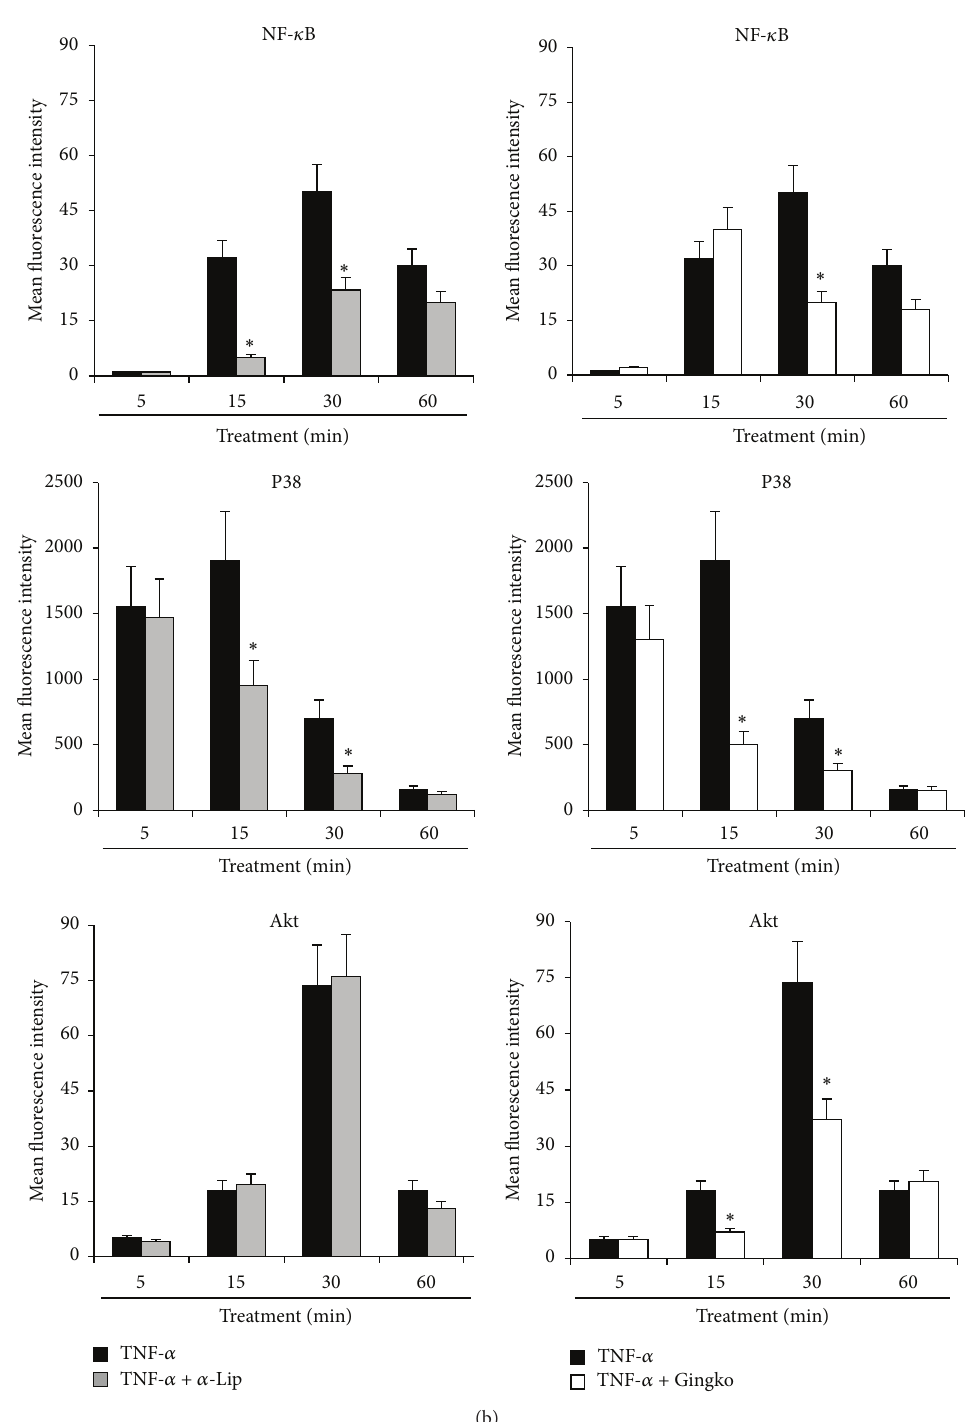
Figure 4: Multiplex analysis of molecular pathways activated in CVD-VEC in response to TNF- 𝛼 stimulation: modulatory effect of 𝛼 -Lipoic acid Ginkgoselect phytosome. Endothelial cells were left untreated (Untr.) or treated with TNF- 𝛼 (5ng/mL) alone (a) or in combination with 𝛼 -Lipoic acid and Ginkgoselect phytosome (preincubation for 1 hour with 𝛼 -Lipoic acid and Ginkgoselect phytosome both at 100 𝜇 g/mL before addition of TNF- 𝛼 ; (b)) before analysis of phosphoprotein levels performed by Luminex system and expressed as mean fluorescent intensity (MFI). In (a), endothelial cells were treated with TNF- 𝛼 for the indicated time points and cell lysates were assayed for phosphoproteins activation. ∗ 𝑃 < 0.05 compared to untreated cells. In (b), VEC cultures were pretreated for 1 hour with 𝛼 -Lipoic acid and Ginkgoselect phytosome prior to stimulation with TNF- 𝛼 for the indicated time points. Cell lysates were assayed for phosphoproteins induction and results expressed as means ± SD of samples assayed in duplicate in four independent experiments. ∗ 𝑃 < 0.05 compared to cells treated with TNF- 𝛼